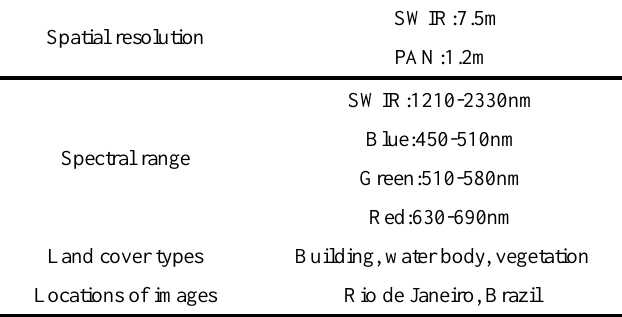
Table 1. Characteristics of the employed WV-3